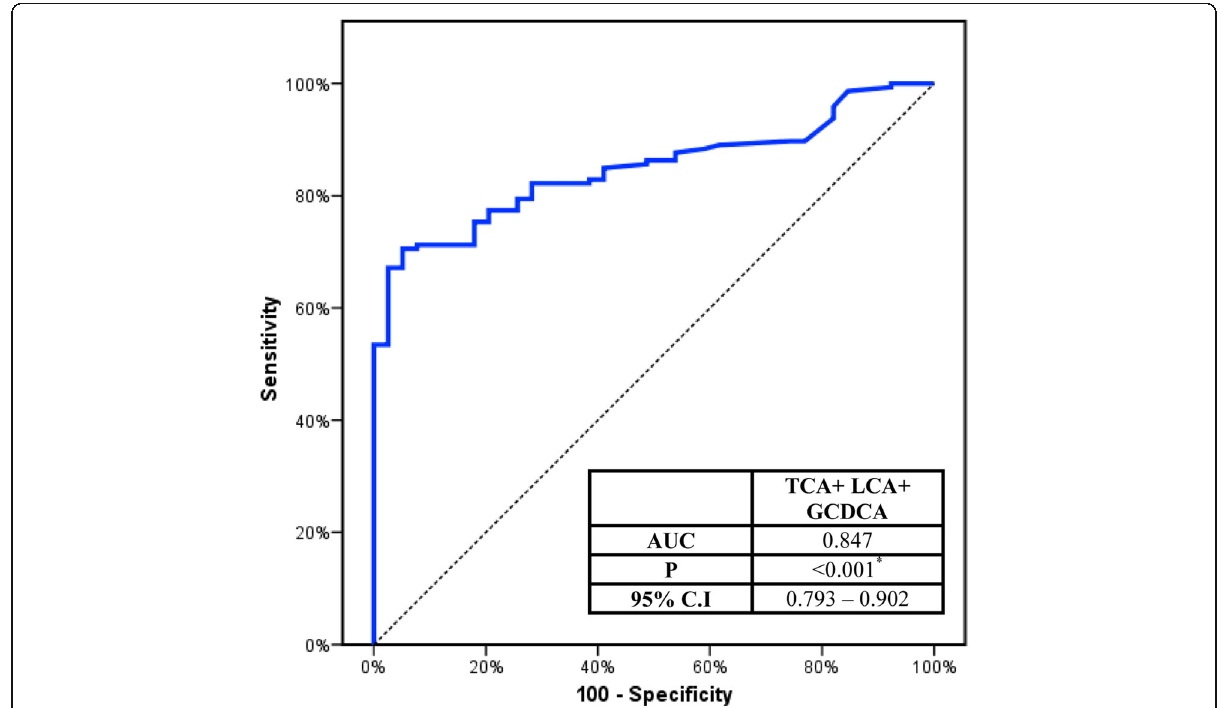
Fig. 2 ROC curve analysis of combined TCA, LCA, and GCDCA to distinguish viral hepatitis group from NAFLD